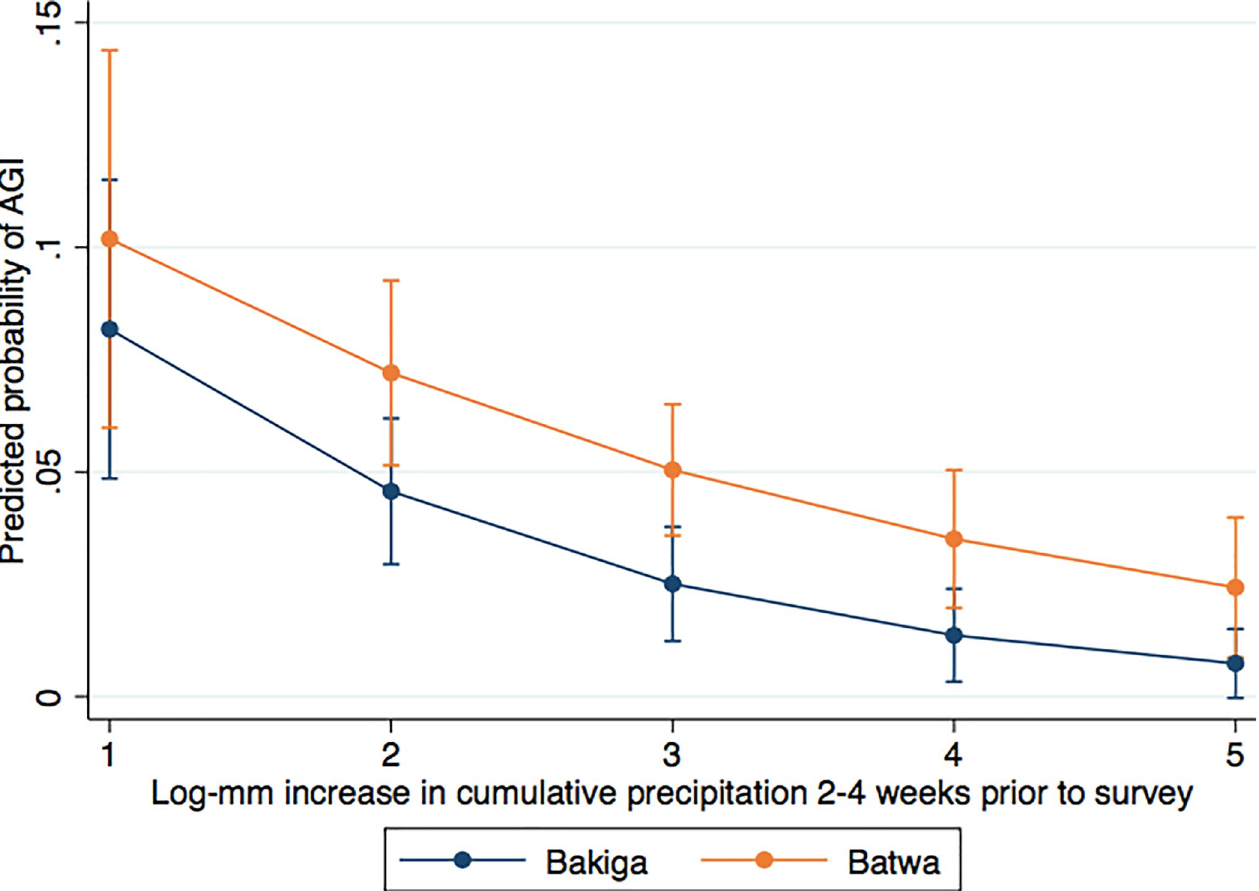
Fig 1. Marginal model predicted probability of AGI by log-mm increase in accumulated precipitation in the 2 to 4 weeks prior to survey for the Bakiga and Batwa in southwestern Uganda (2013–2014). Models included community-level random effects and controlled for wealth.